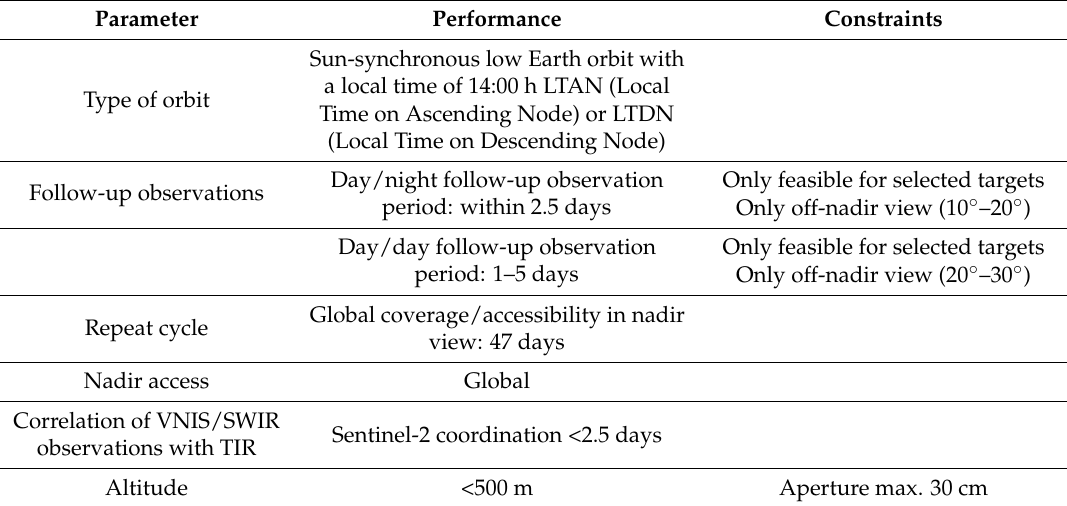
Table 2. Orbit requirement and